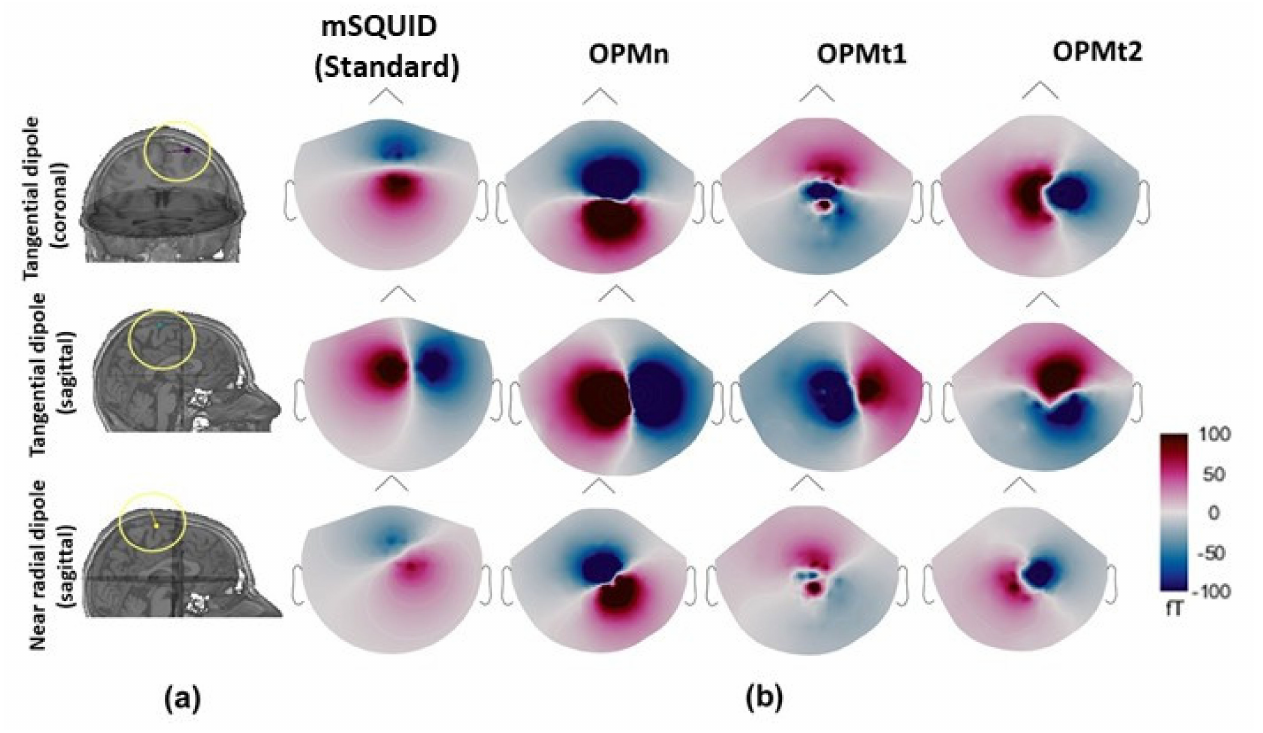
Figure 3. ( a ) The position of the dipoles with radial and tangential orientations in the somatosensory region of an adult subject. ( b ) Topographic maps of the magnetic field components of the radial and tangential dipoles for mSQUID, OPMn, OPMt1, and OPMt 2 . The shape of the 2D map differed from one type of sensor array to